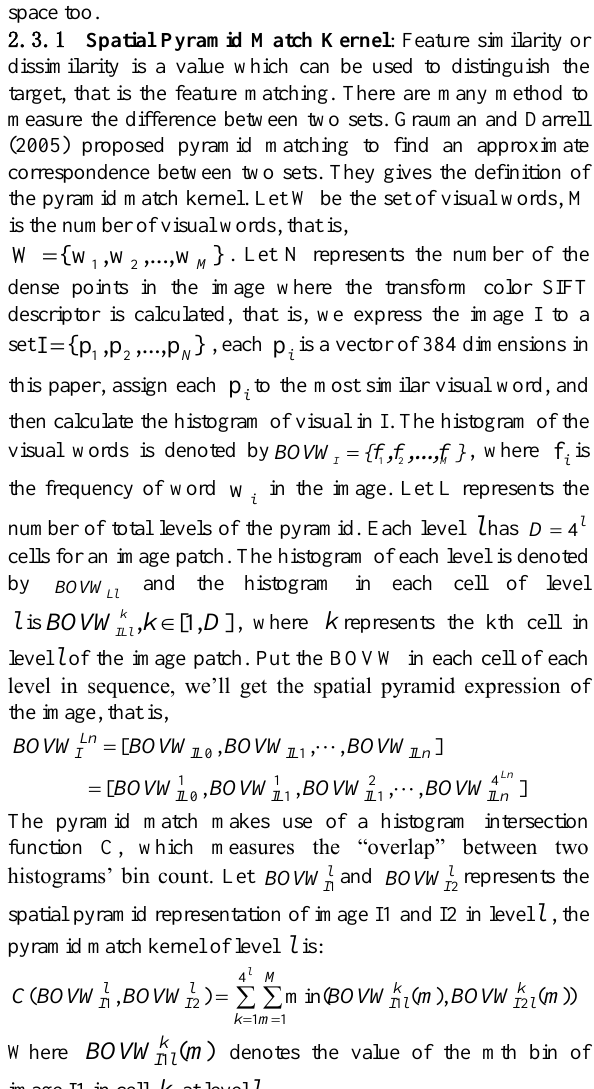
Figure 4. Value of the MS-HOG & HSV